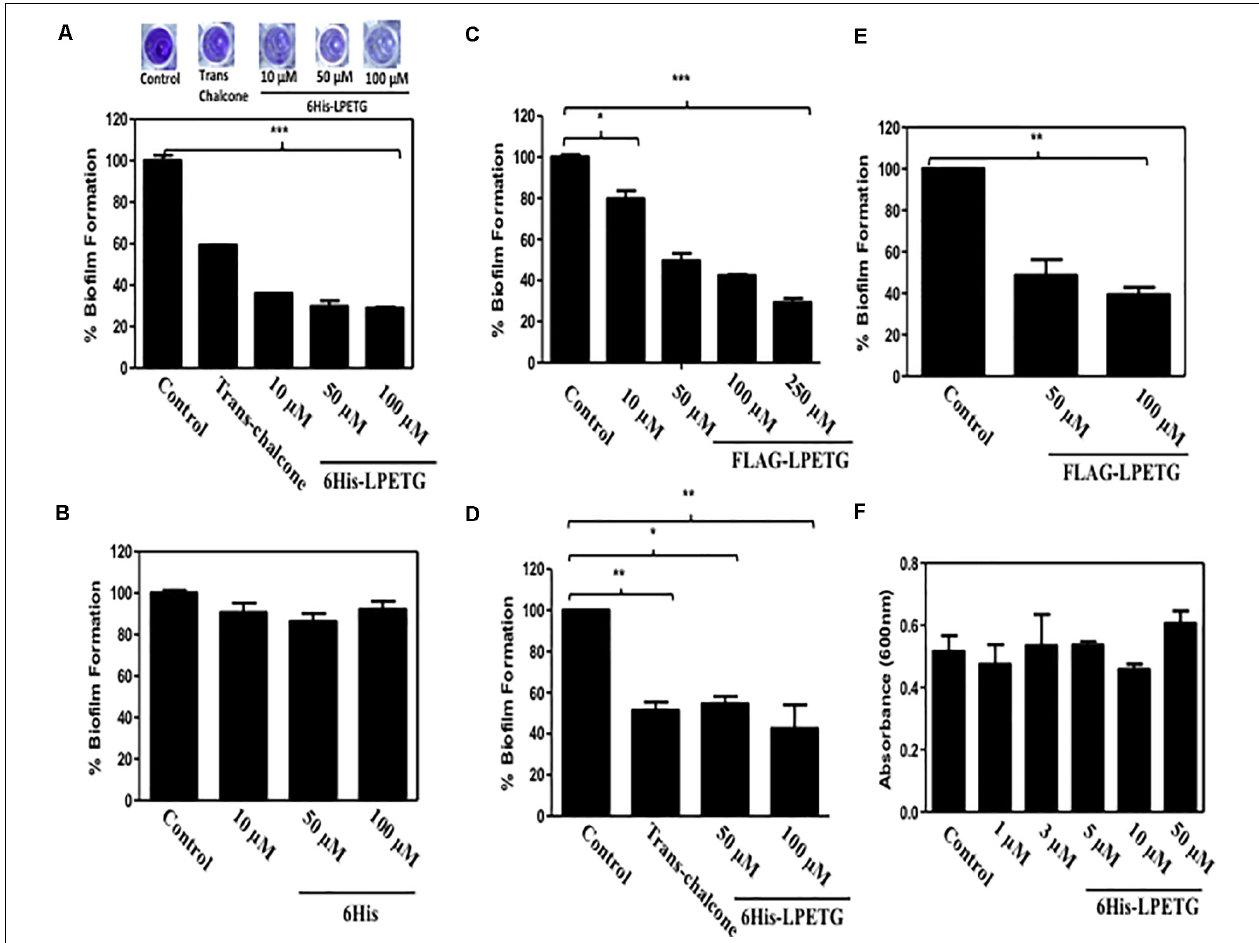
FIGURE 2 | 0.1% Crystal Violet assay with S. aureus using (A) 6His-LPETG, (B) 6His, and (C) FLAG-LPETG at indicated concentrations. One hundred micro meter Trans-chalcone was used as positive control in crystal violet assay. Peptide was incubated with 1/100 diluted S. aureus cell culture at indicated concentrations and absorbance (OD 600 ) was measured after 24 h. 0.1% Crystal Violet assay with E. faecalis using (D) 6His-LPETG and (E) FLAG-LPETG at indicated concentrations. (F) S. aureus cell viability assay in the presence of 6His-LPETG. All the experiments weredone is triplicates and P < 0.05 was considered as significant. Error bars are mean ± SEM. * p < 0.05, ** P < 0.01, *** p <